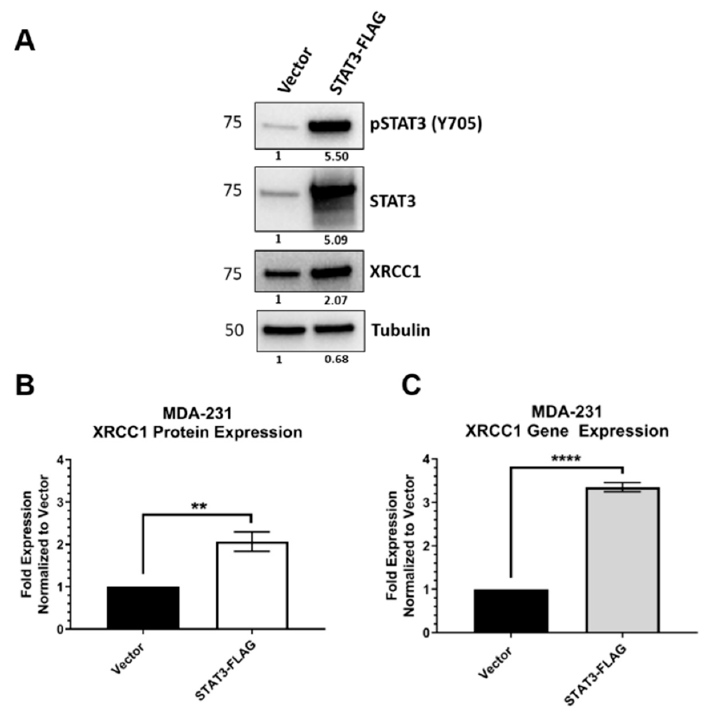
Figure 4. Ectopic overexpression of STAT3 increases the expression of XRCC1 in MDA-231 cells. ( A ) Representative immunoblot of phospho-STAT3 (Y705), STAT3 and XRCC1 protein expression following ectopic expression of STAT3-FLAG. α -tubulin is used as a loading control. ( B ) Quantification of protein expression changes in XRCC1 resulting from ectopic expression of STAT3-FLAG. ( C ) Quantification of XRCC1 mRNA expression following ectopic expression of STAT3-FLAG. ** p < 0.01, **** p <